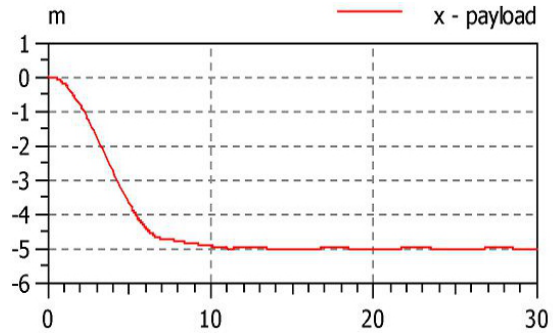
Figure 18. Set point was set to 2 m. Rise time of ca. 4 s with no overshoot. Oscillation of ± 1 cm.